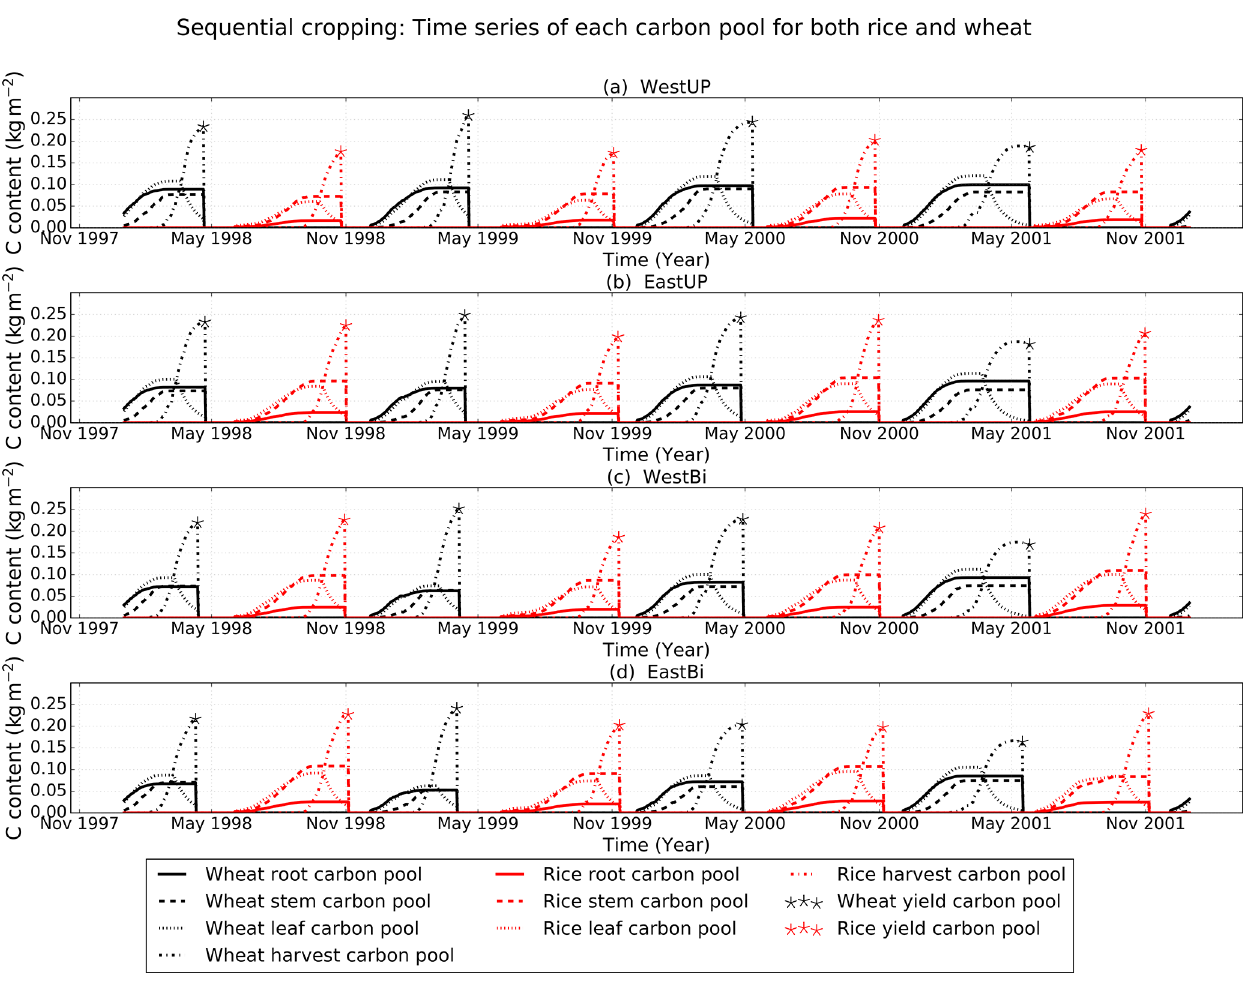
Figure B7. Time series of each crop carbon pool: leaf (solid lines), root (dashed), stem (dotted) and harvest (dash–dot) with the JULES yield at the time it is output by the model (asterisks) for rice (red) and wheat (black) at each of the India locations shown in Fig. 3 for a subset of years of the simulation between 1998 and